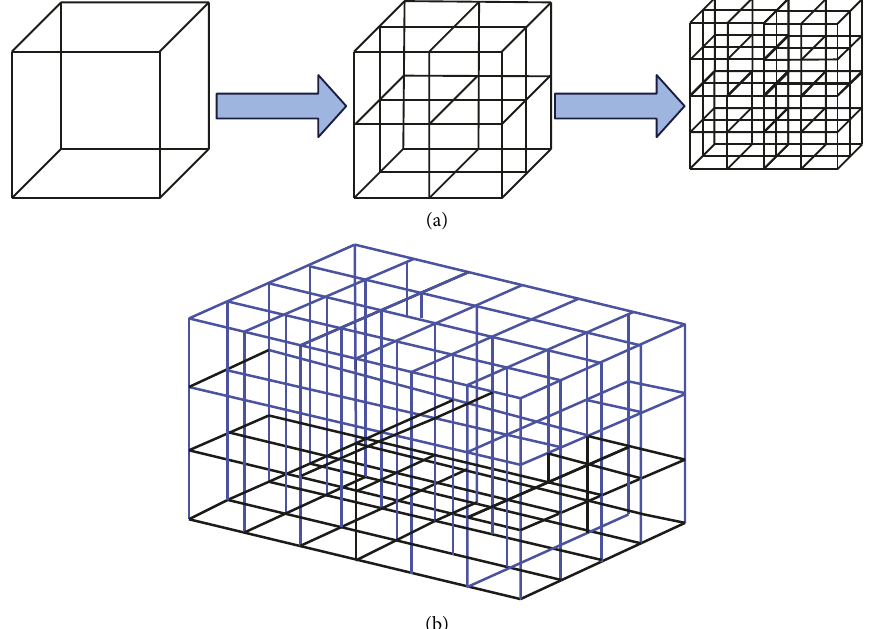
Figure 4: Pixel division method of target area. (a) Division method of the ROI. (b) An example of a target